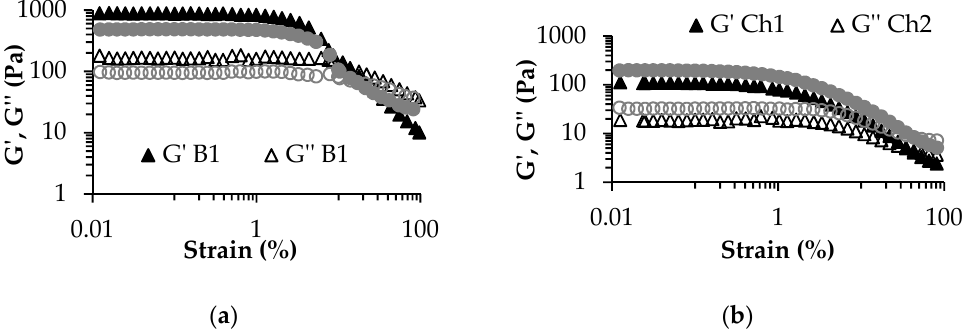
Figure 1. Rheological behavior of ( a ) broad bean- and ( b ) chickpea-based fermented products during low-amplitude oscillatory strain sweep test. B1—broad bean-based product fermented with SC1; B2—broad bean-based product fermented with SC2; Ch1—chickpea-based product fermented with SC1; Ch2—chickpea-based product fermented with SC2.